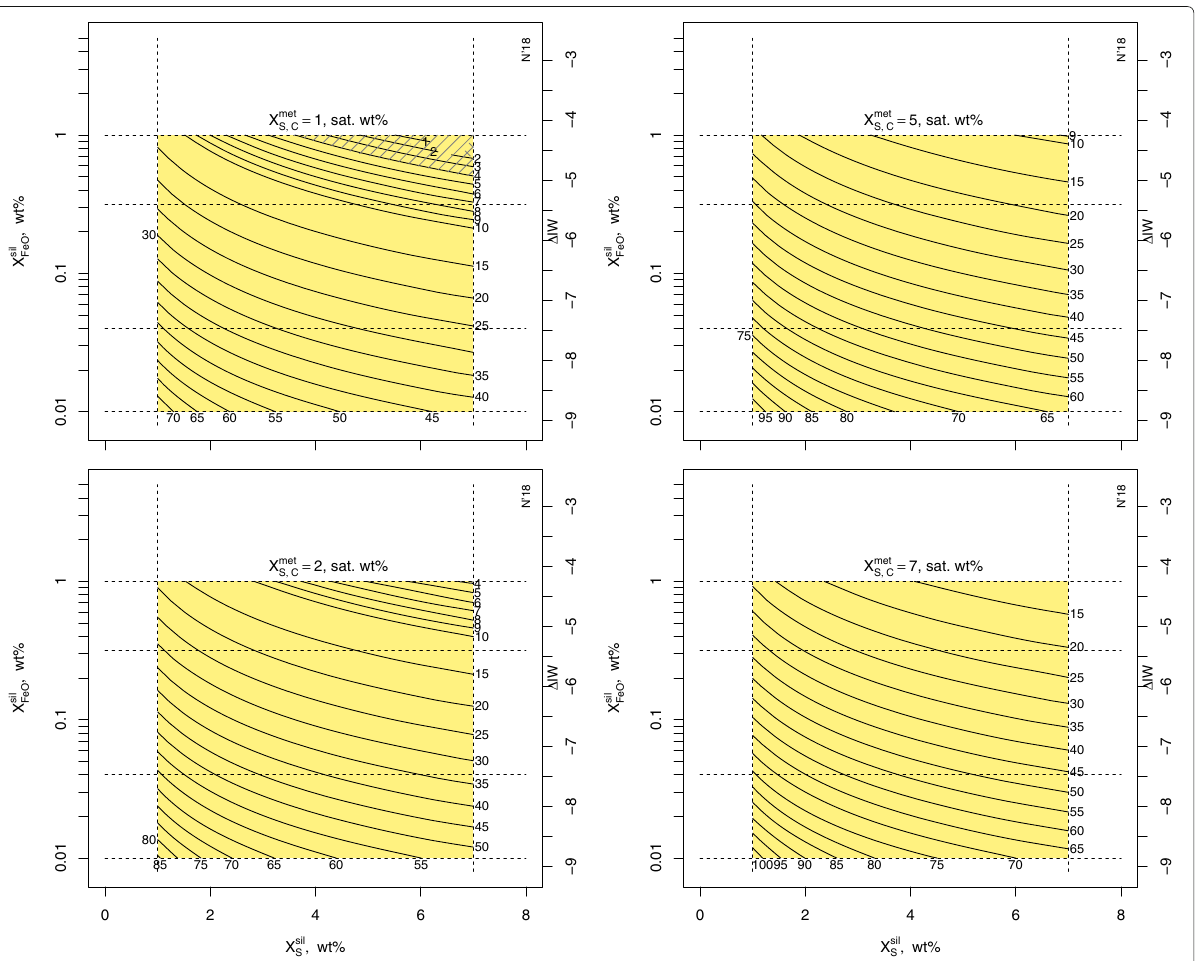
Fig. 2 Compatibility of S and FeO content of Mercury’s mantle with pressure of metal/silicate equilibration for various core S contents (1, 2, 5, and 7 wt%). Label on each panel gives the core metal S content at C saturation conditions (see text). Lines are contours of the pressure (GPa) of metal/silicate equilibrium. Colored box depicts limits on S and FeO in silicate discussed in text (see Table 3 for compositions). Lines of constant FeO content across box indicate estimates of Mercury compositions from two sources: Nittler et al. (2018) mantle composition (0.04 wt%) and Namur et al. (2016) ( (cid:6) IW = − 5.4). Equivalent oxygen fugacity in log units relative to the iron-wüstite buffer on right assuming 70 wt% Fe in metal. Hatched regions flag pressures outside Mercury’s 2 / 7 ≤ P / P CMB ≤ 2 / 3 limits. Liquid immiscibility in Fe-Si-S (Morard and Katsura 2010) potentially affects only = 2, but does not substantially affect the results the lowest pressures at X met S